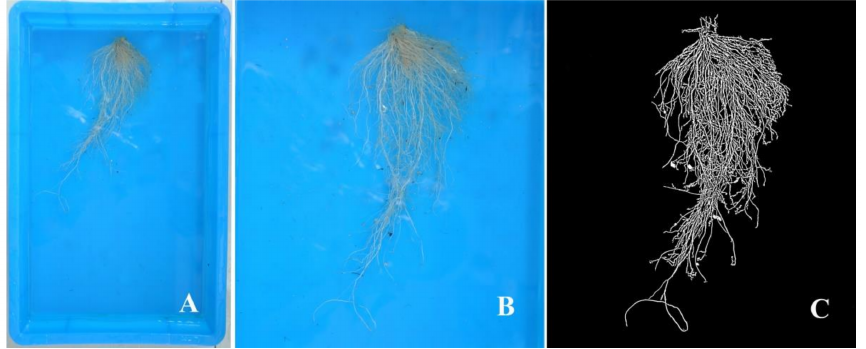
Figure 1. The entire root was immersed and spread out in a 40 × 25 × 10 cm square plastic container filled with tap water to a depth of 3 cm ( A ), the image was re-cropped after being scaled ( B ), and changed to a threshold image ( C ) with GiA Roots software, for root characteristics